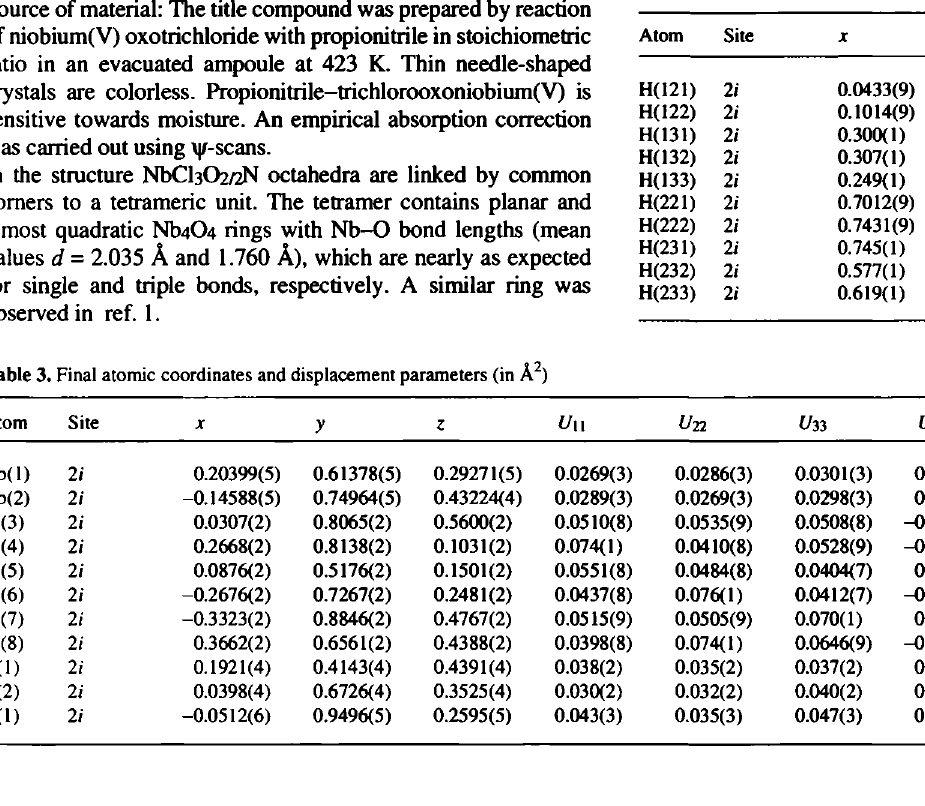
Table 2. Final atomic coordinates and displacement parameters (in